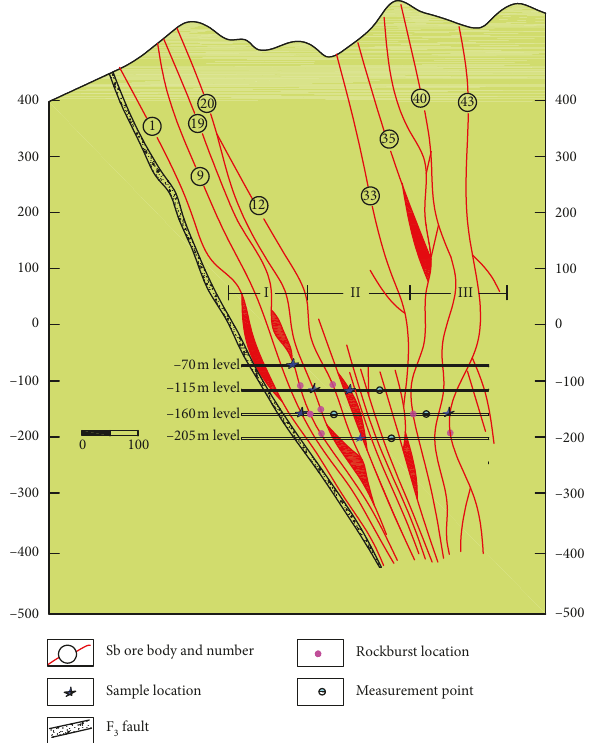
Figure 2: No. 0 exploratory grid cross section of Zhazixi Antimony